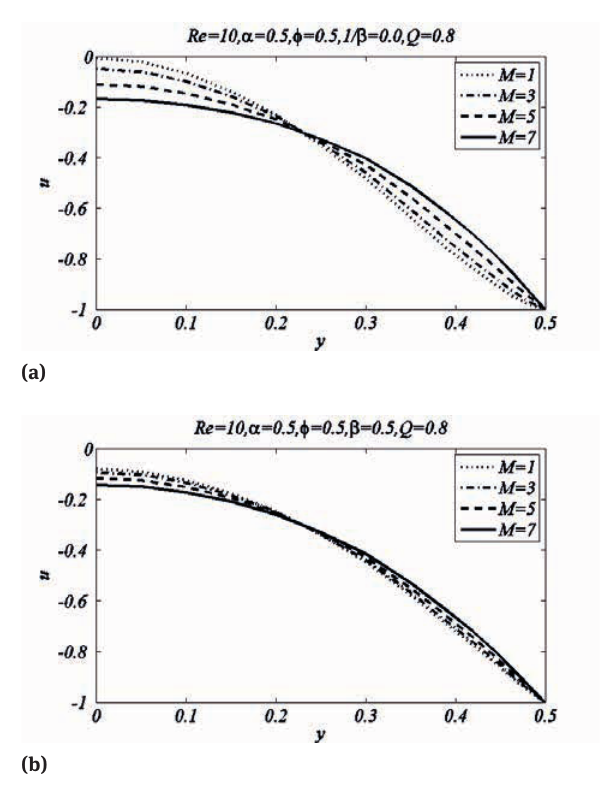
Fig. 4: Longitudinal velocity distribution for different values of Q .